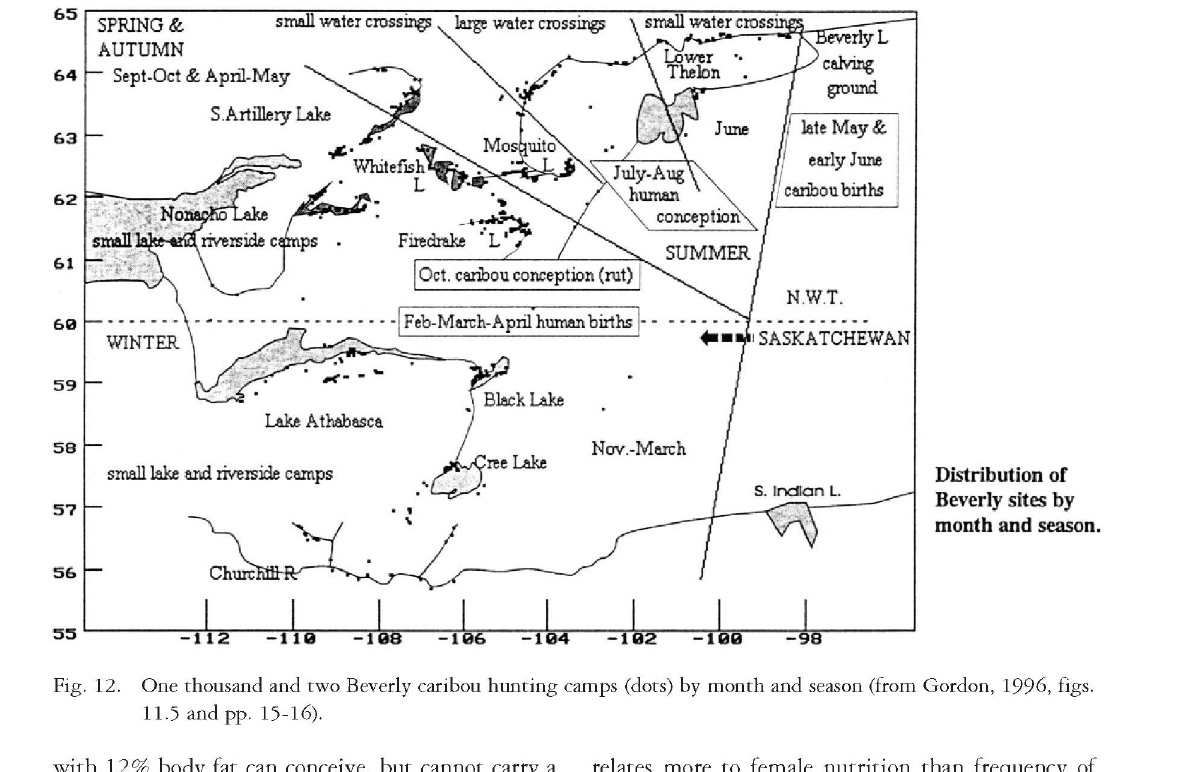
Fig. 12. One thousand and two Beverly caribou hunting camps (dots) by month and season (from Gordon, 1996, figs. 11.5 and pp.